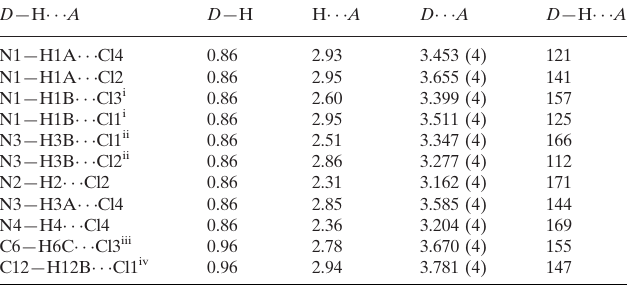
Hydrogen-bond geometry (A˚ , (cid:4)